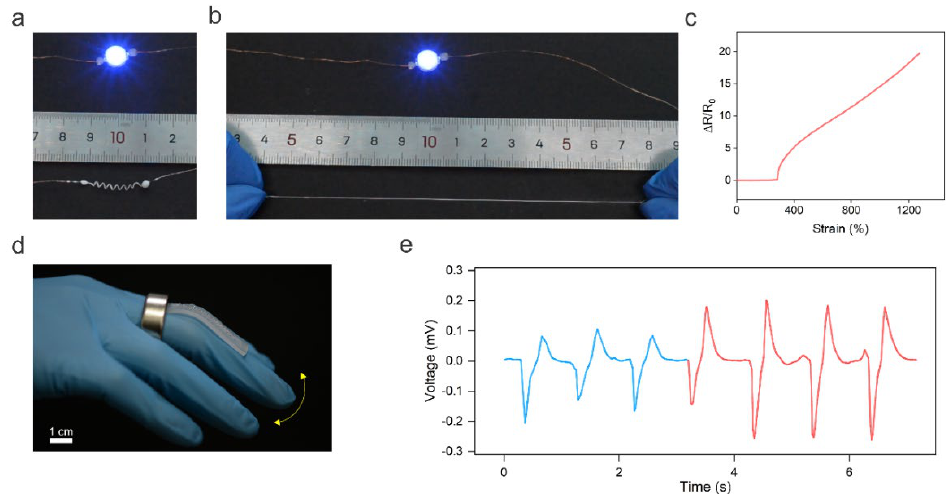
Figure 3. 3D helical LM fibers. ( a ) The helical LM fiber is connected in series with a blue LED. ( b ) The helical LM fiber maintained its conductivity under stretching. ( c ) Change in relative resistance of the LM fiber as a function of tensile strain. ( d ) Optical image of the LM fiber-based strain sensor to monitor the finger bending based on Faraday’s law of electromagnetic induction. ( e ) Real-time change in the induced voltage in response to finger bending.